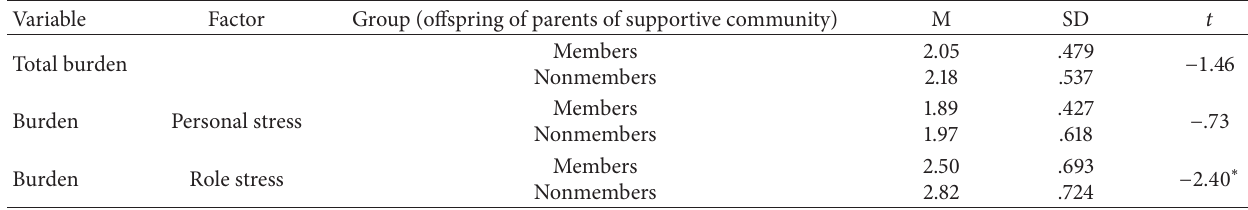
Table 2: Differences in burden between offspring of supportive community members ( 𝑁 = 55 ) and nonmembers ( 𝑁 = 64 ). Variable